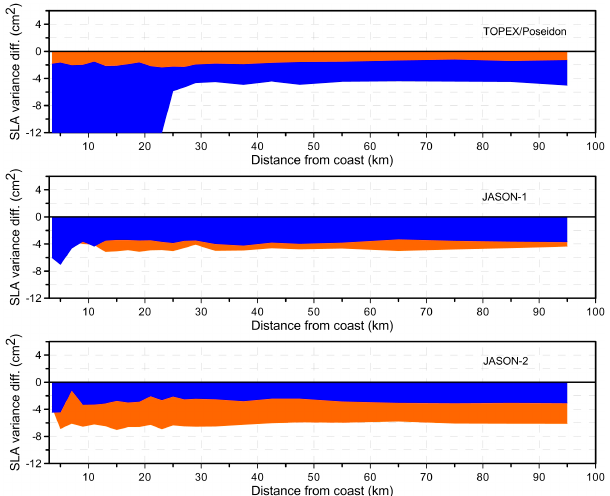
Figure 6. SLA variance differences of WTC, function of distance from coast, GPD+ − ERA (orange) and GPD+ − MWR (blue), for TOPEX/Poseidon cycles 1 to 364, Jason-1 cycles 1 to 259 and Jason-2 cycles 1 to 280 .